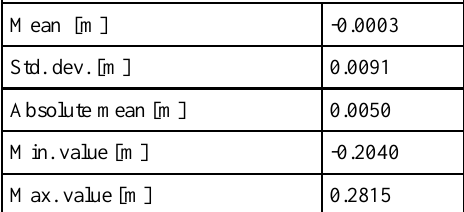
Table 5. Basic statistics about M3C2 distance data from TLS- SLR analysis.